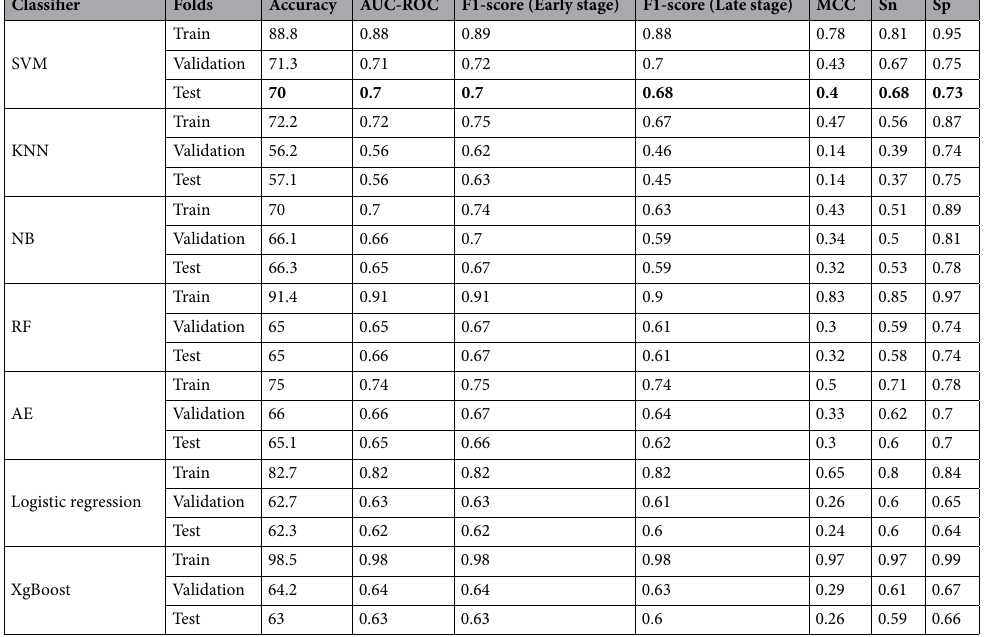
Table 1. The performance of classifiers based on 77 selected miRNAs. Significant values are in bold. AUC: The area under the curve, ROC: receiver operating characteristic curve, MCC: Matthews Correlation Coefficient, Sn: sensitivity, Sp: specificity.